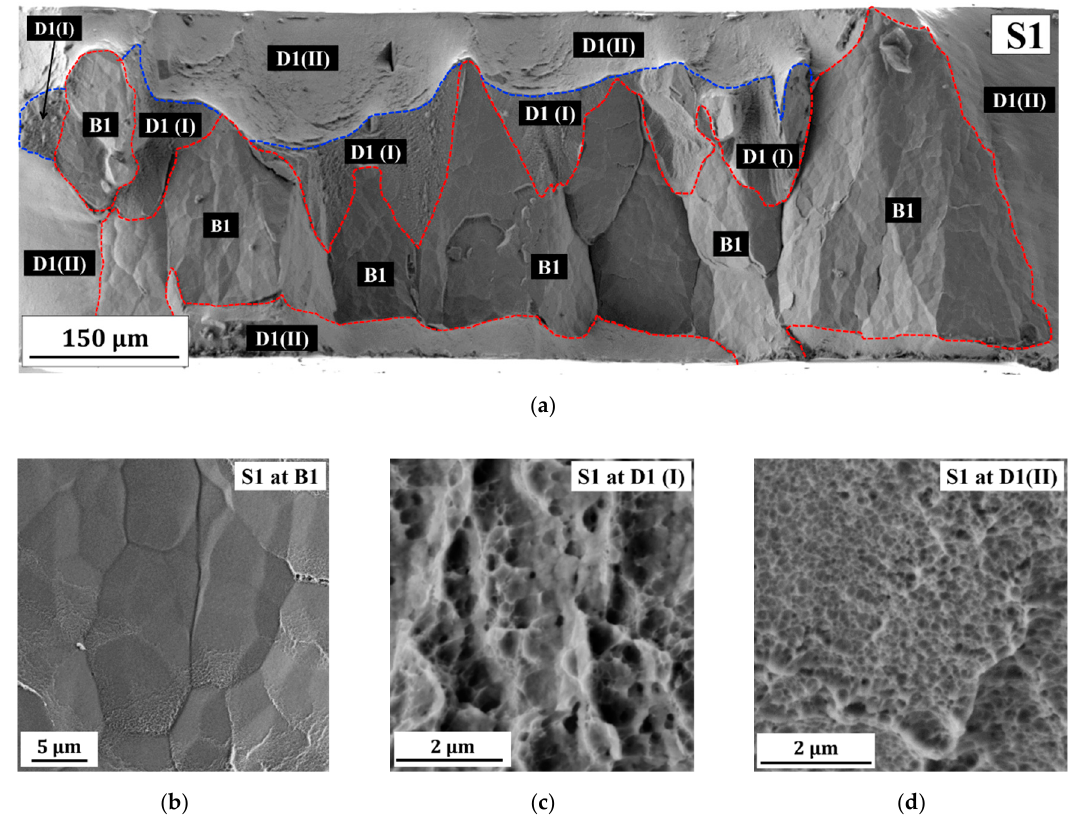
Figure 4. ( a ) A Secondary electron (SE) image of fracture surface of sample 1 (S1) shows brittle (B1) and ductile (D1(I) and D1(II)) fracture regions; ( b – d ) SE images of detailed fracture surface of S1 at three different regions marked at ( a ), which are ( b ) brittle (B1) and ( c , d ) ductile (D1(I), and D1(II)) fracture regions.